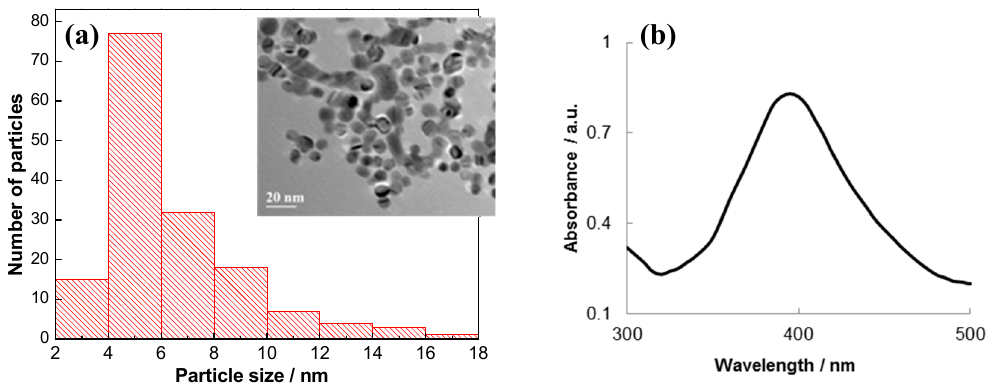
Figure 2. TEM-derived Ag nanoparticle (NP) size distribution and TEM image of Ag NPs (inset) ( a ); UV/Vis absorption spectra of clear yellow colloidal Ag (Ag NPs), optical path length of 1.0 cm, blank—deionized water (b).